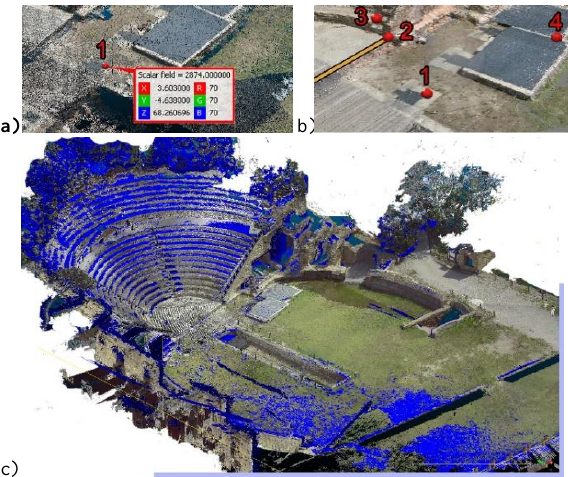
Figure 4: An example of common points chosen in the TLS (a) and